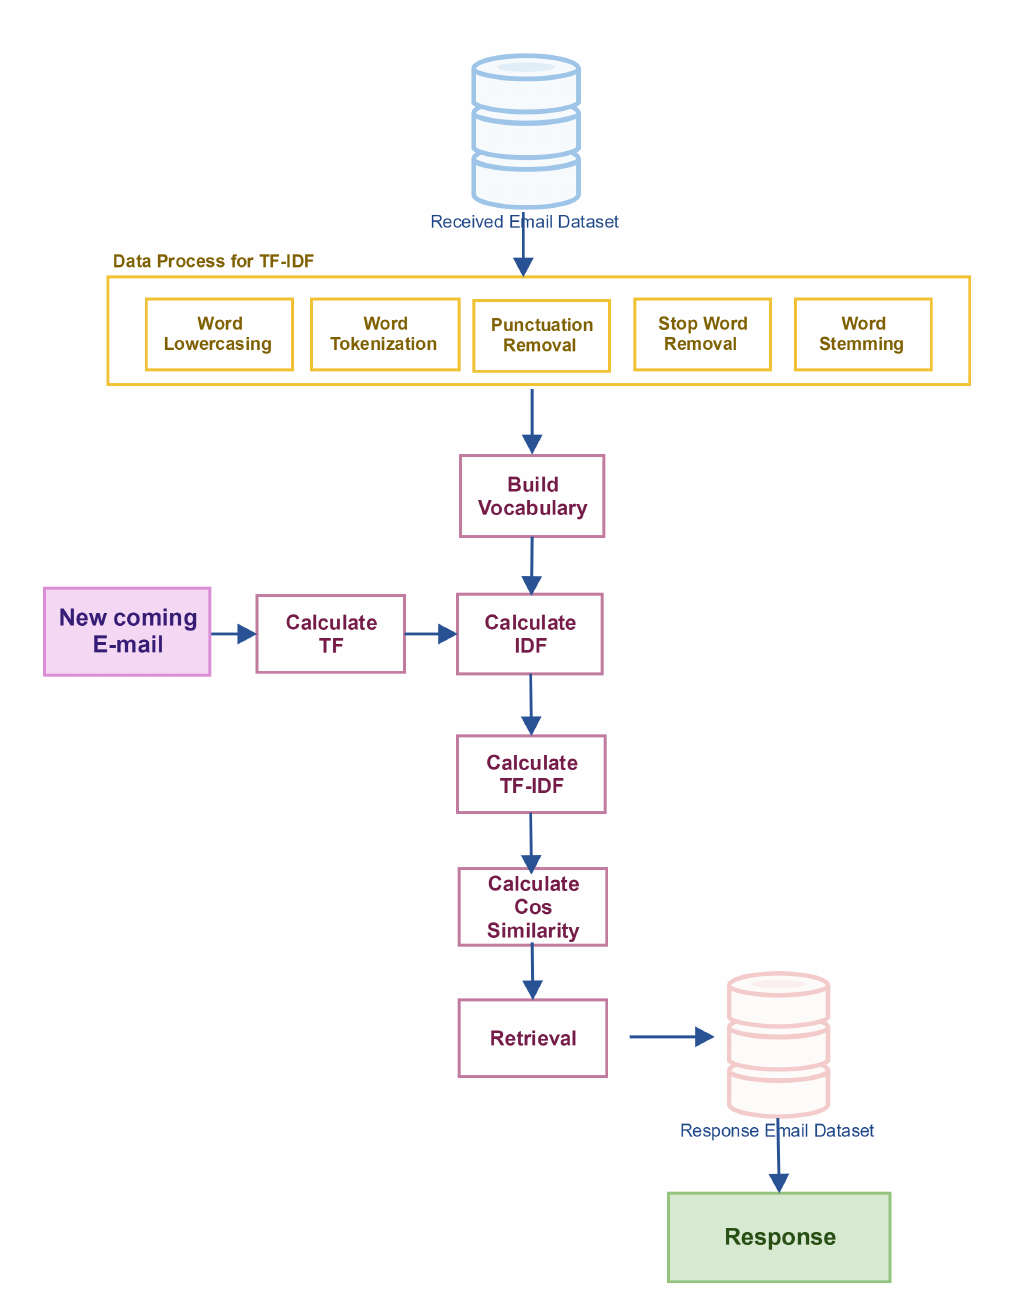
Figure 2. Term Frequency-Inverse Document Frequency (TF-IDF) Based